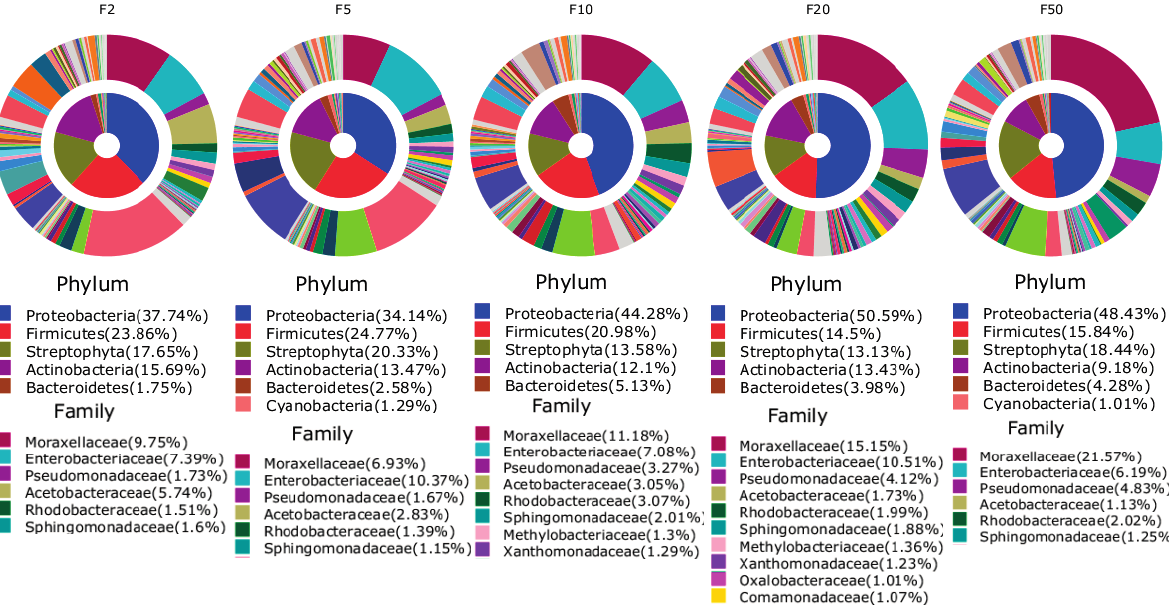
Figure 3. Average composition of bacteria from each sample (inner area: Phylum, outer area: Family). Only bacterial phyla and families that had a relative abundance of 1% or greater are